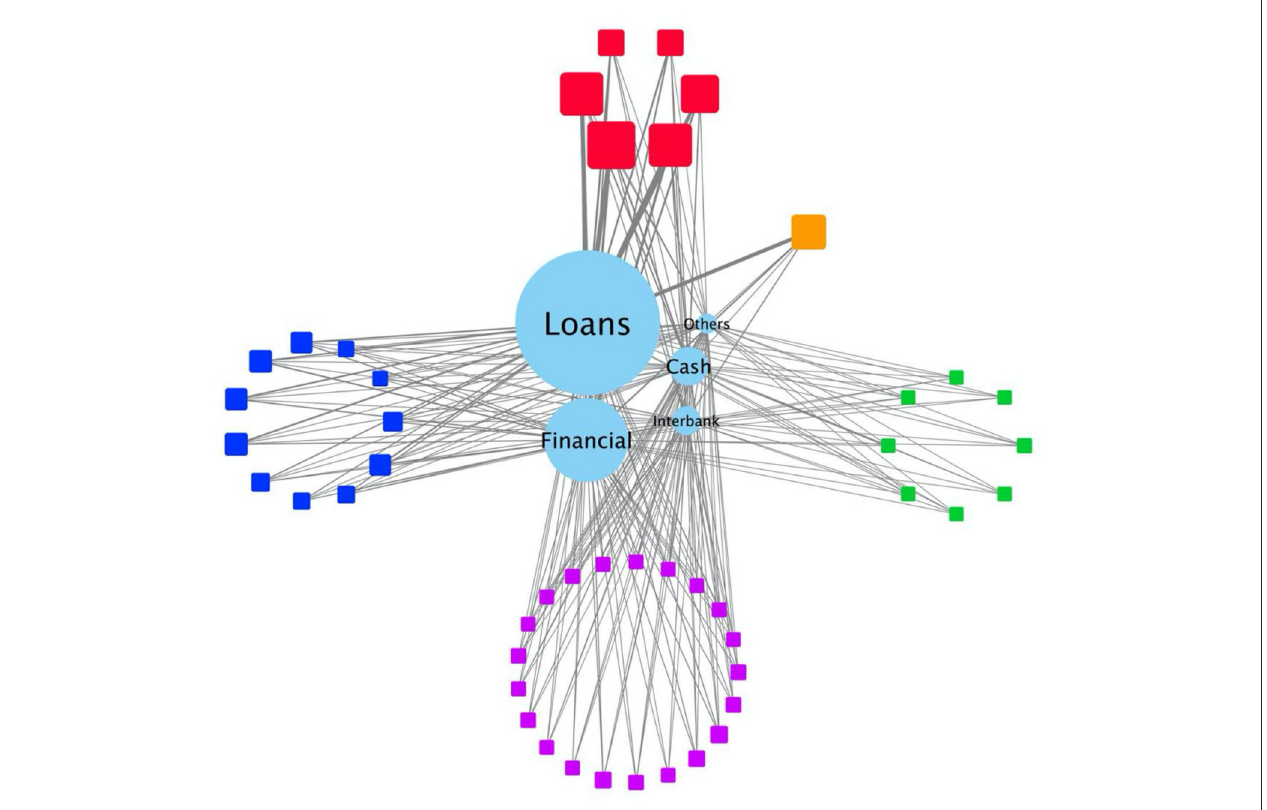
FIGURE 3 | The bank-asset bilateral network of the Chinese banking system. The circle represents the asset class; the rectangle represents the bank class; the size of each node represents the size of its total assets; the thickness of each connecting line represents the total value of each asset class invested by each bank; besides, in the rectangular node: red represents state-owned banks; purple means joint-stock commercial banks; light blue means city commercial banks; dark blue means rural commercial banks; yellow means policy